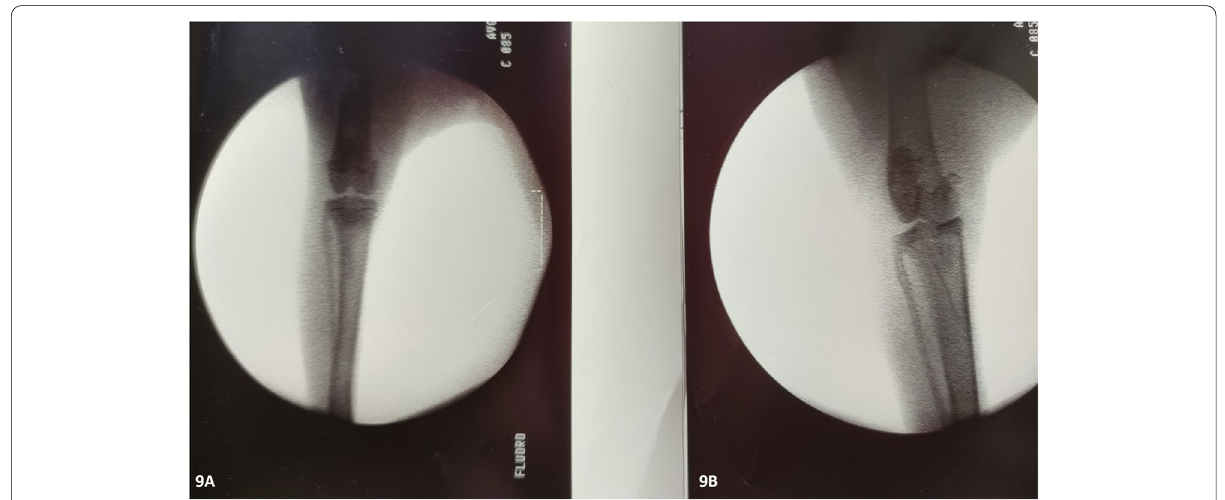
Fig. 7 Comparative radiographic images just before (9 A ) and after 16‑weeks post‑surgery (9 B ) showing medial joint space